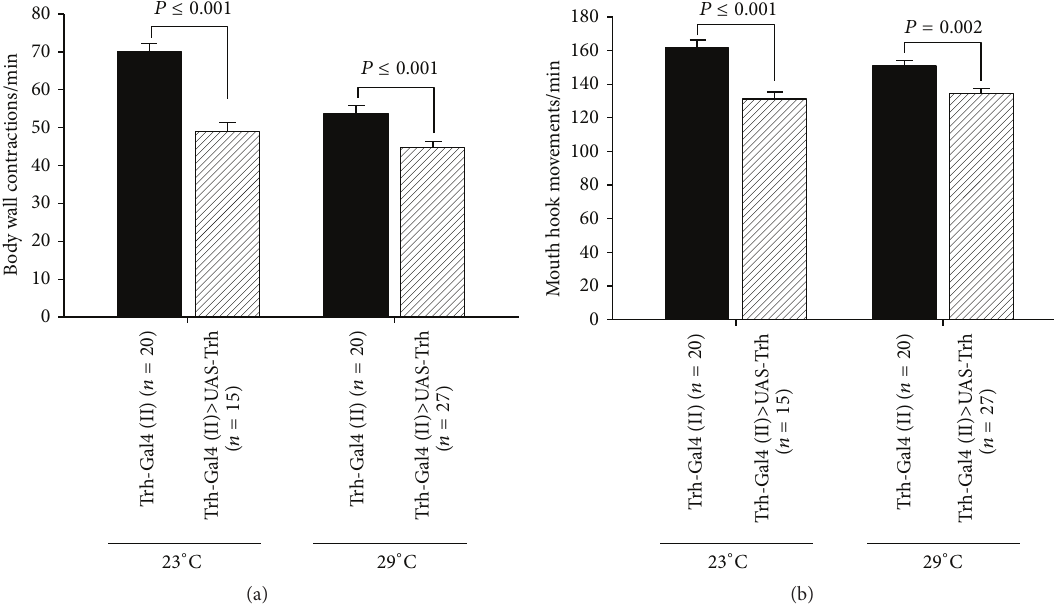
Figure 4: Overexpression of 5-HT biosynthesis rate-limiting enzyme, tryptophan hydroxylase (Trh), in serotonergic neurons. (a) Trh overexpression reduces body wall contractions. (b) Trh overexpression significantly decreased mouth hook movements as an indicator for feeding behavior. The flies were raised at 23 ∘ C as well as at 29 ∘ C to manipulate the expression level of transcriptional activator Gal4. Student’s 𝑡 -test was performed to carry out comparison between